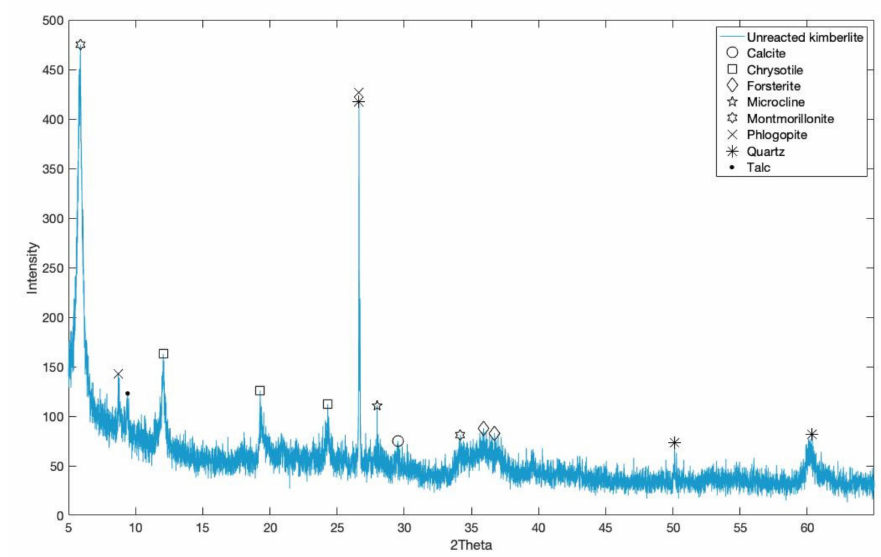
Figure 1. X-ray di ff raction (XRD) di ff ractogram of fine processed kimberlite (FPK), sourced from the Gahcho Ku é Diamond Mine, Northwest Territories,